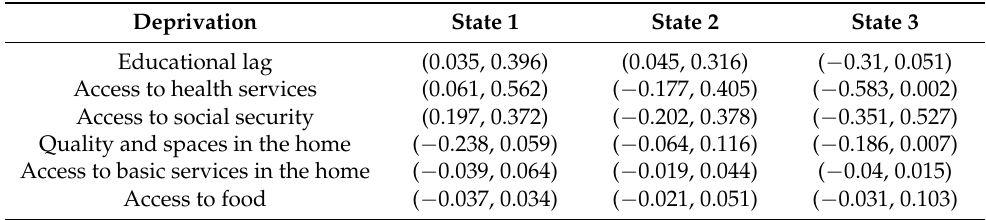
Table 9. Bonferroni simultaneous intervals for diabetic and non-diabetic populations by states and social deprivation (percentages) at a 95%